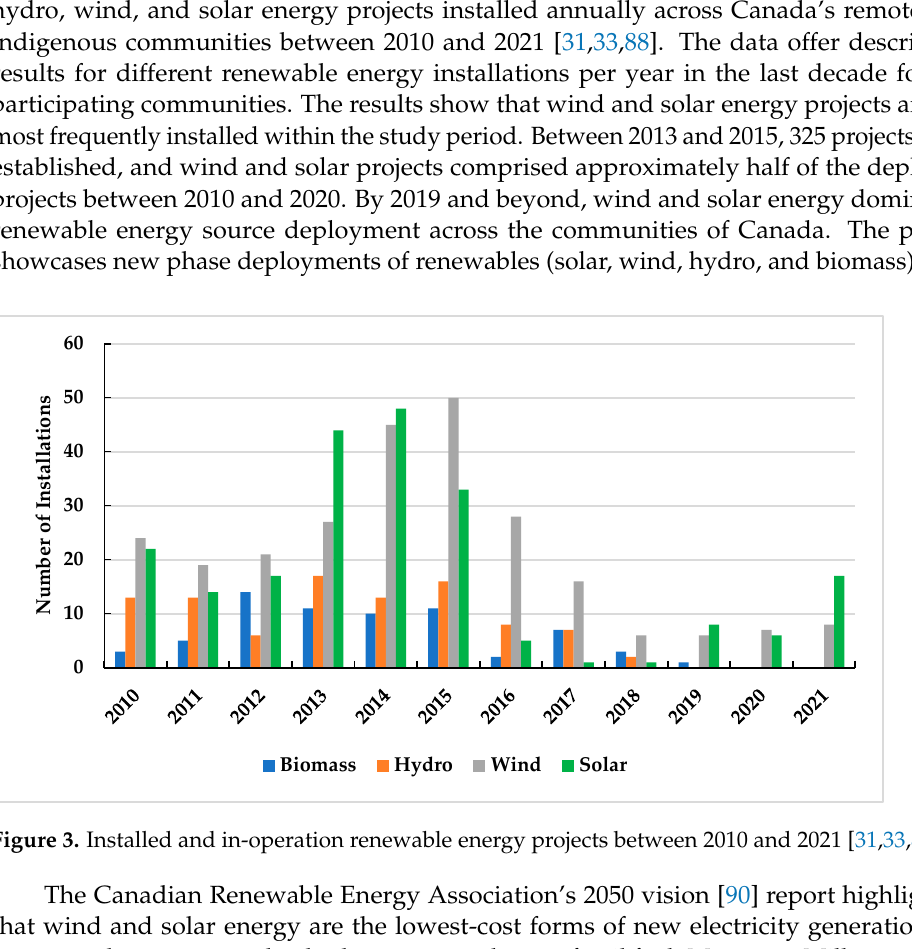
Figure 2. Number of biomass, hydro, solar, and wind projects in operation and development in Canada (2010–2021) [31,33,88].